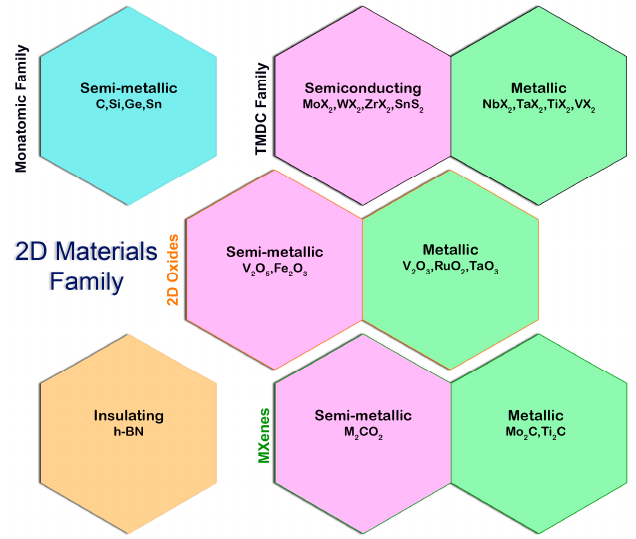
Figure 1. 2D materials family [18]. Reprinted with permission from ref. [18]. Springer Nature and Copyright Clearance Center.